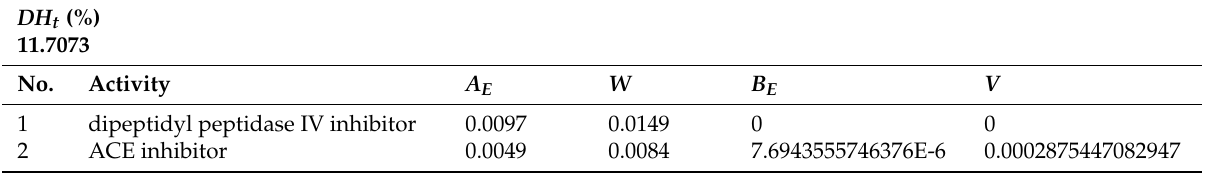
Table A56. A E , DH t , W , B E and V values from RubisCO of Halophila stipulacea . In silico enzymatic cleavage was carried out by using V-8 protease (Glutamyl